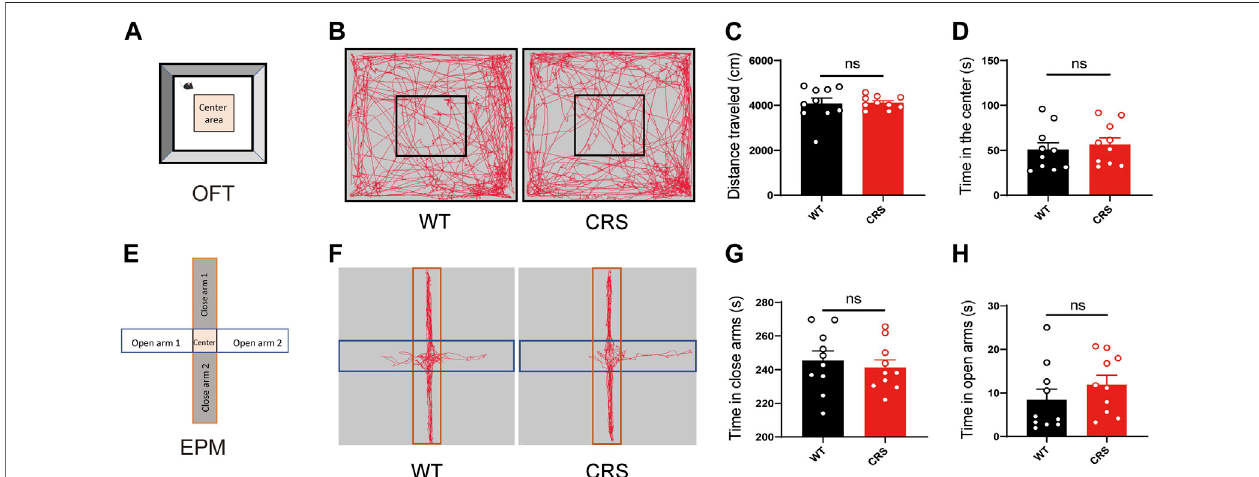
FIGURE 2 | Locomotion and anxiety did not change in CRS mice. Scheme of the OFT (A) . Representative images of movement trace in OFT (B) . The distance traveled in OFT did not change in CRS mice (WT: n = 10; CRS: n = 10) (C) . Time in the center did not change compared with WT controls (D) . Scheme of the EPM (E) . Representative images of movement trace in EPM (F) . Time in closed arms did not change in CRS mice (WT: n = 10; CRS: n = 10) (G) . Time in the open arms did not change compared with WT controls (H) . The data were analyzed by unpaired t -test. CRS, chronic restraint stress; OFT, open fi eld test; WT, wild-type; EPM, elevated plus maze.